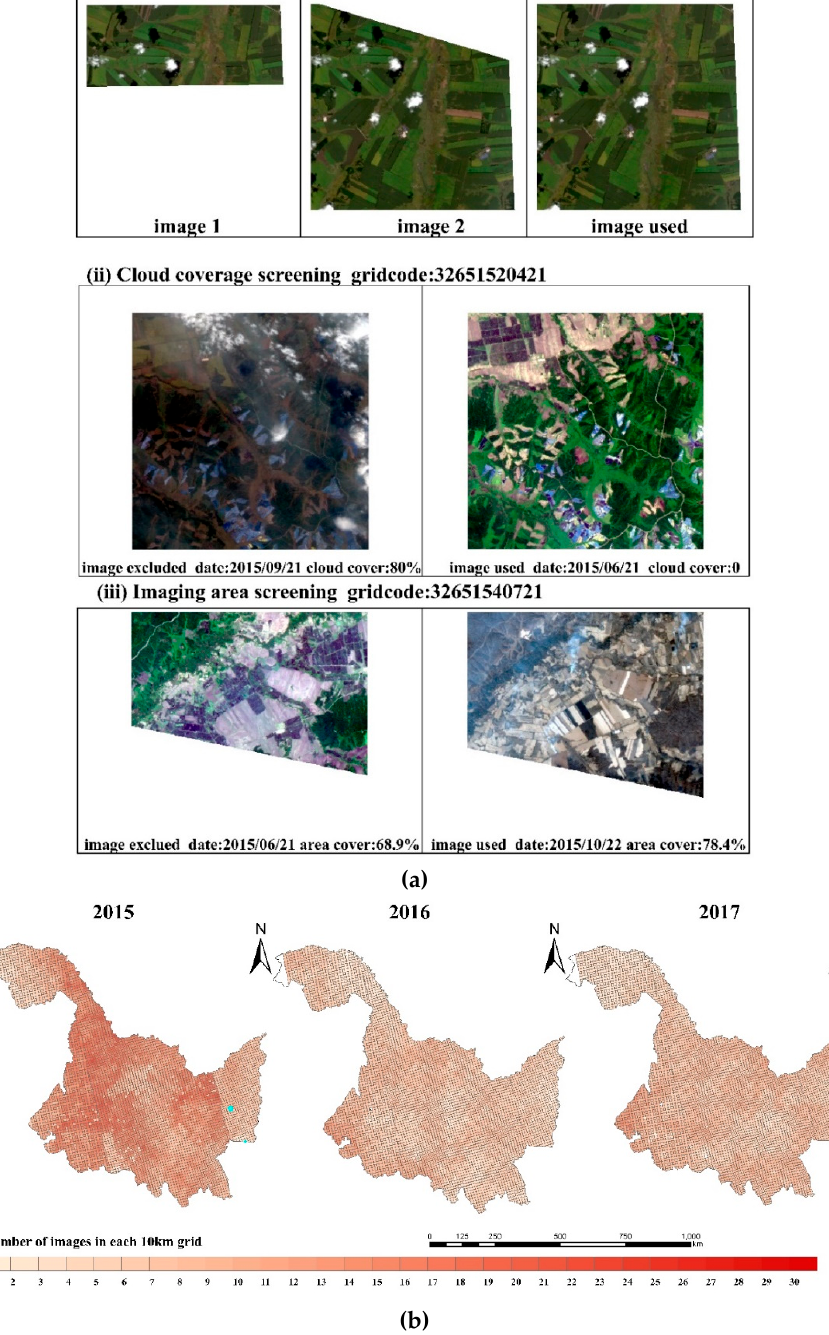
Figure 9. ( a ) Data selection for three data quality problems. ( b ) Available dates count statistics of Heilongjiang Province in 2015, 2016 and 2017.